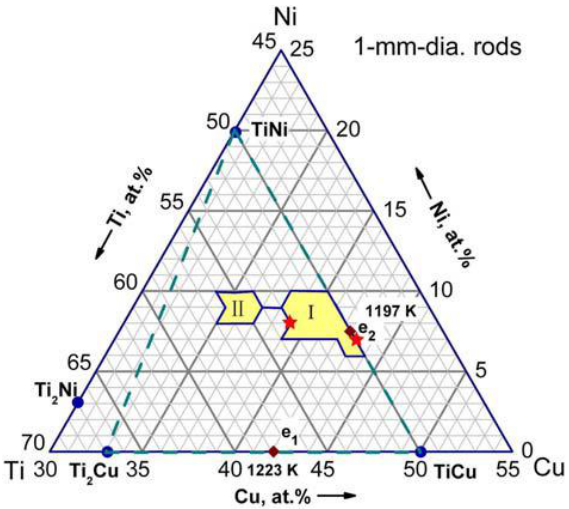
Figure 3. BMG formation composition zone with t max = 1 mm in the ternary Ti–Cu–Ni system. Reproduced with permission from [41]. Copyright 2008, Springer.